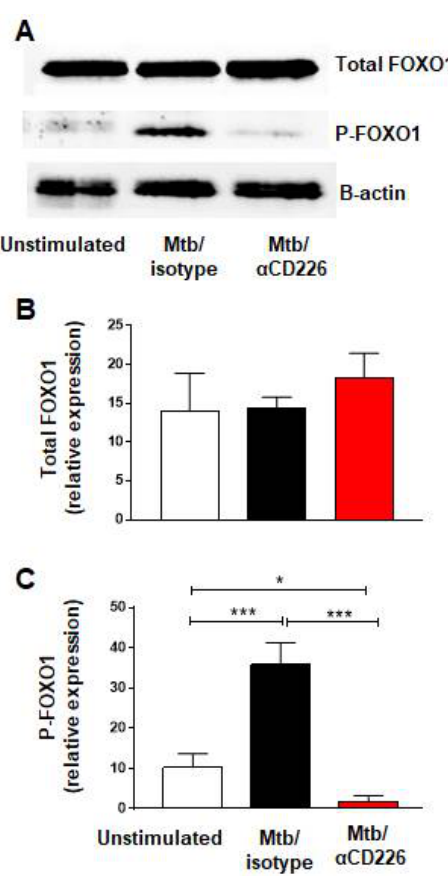
Figure 2. CD226 blockade reduced FOXO1 phosphorylation in NK cells from LTBI+ people after stimulation with Mtb. ( A ) Western blot from NK cells unstimulated or stimulated with γ-Mtb for 48 h and treated with isotype or blocking CD226 antibody. ( B ) Total FOXO1 and ( C ) phosphorylated FOXO1 (n = 5). Mean ± s.d. ANOVA. * p < 0.05, *** p <